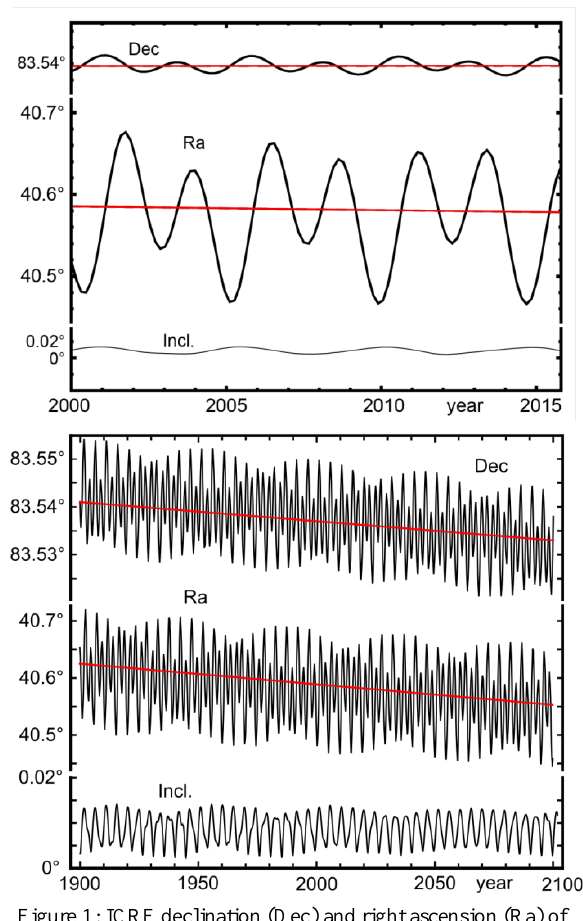
Figure 1: ICRF declination (Dec) and right ascension (Ra) of Enceladus’ orbit pole determined from the ephemeris data. The top and bottom panel depict the short-term (15 years) and long- Table 1: Shape parameters for Enceladus. References: term (200 years) evolution, respectively. The orientation at the * (Dermott and Thomas, 1994), ** (Thomas et al., 2007; J2000 reference epoch is (𝐷𝑒с, 𝑅𝑎 ) = (83.538°,40.579°). Red Archinal et al., 2011), *** (Thomas et al., lines indicate the orientation of Saturn’s spin pole, which averages the oscillating orbit pole orientation. The lower curves show the inclination of the orbit pole to Saturn’s spin pole, varying between 0.0032° and 0.0139° around a mean value of 0.0086°.